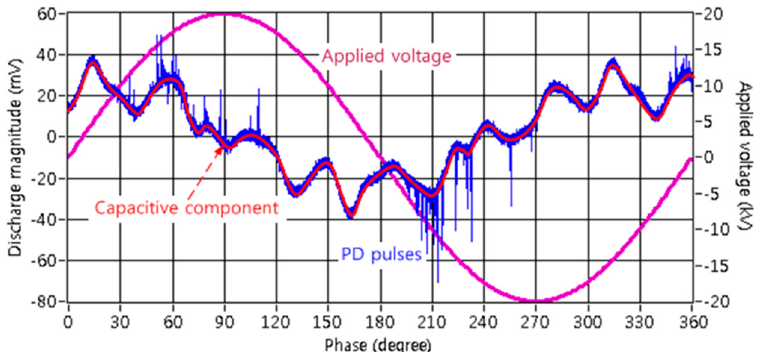
Figure 1. Partial discharge (PD) signal detected within a cycle of applied voltage in gas-insulated switchgear (GIS) spacer.